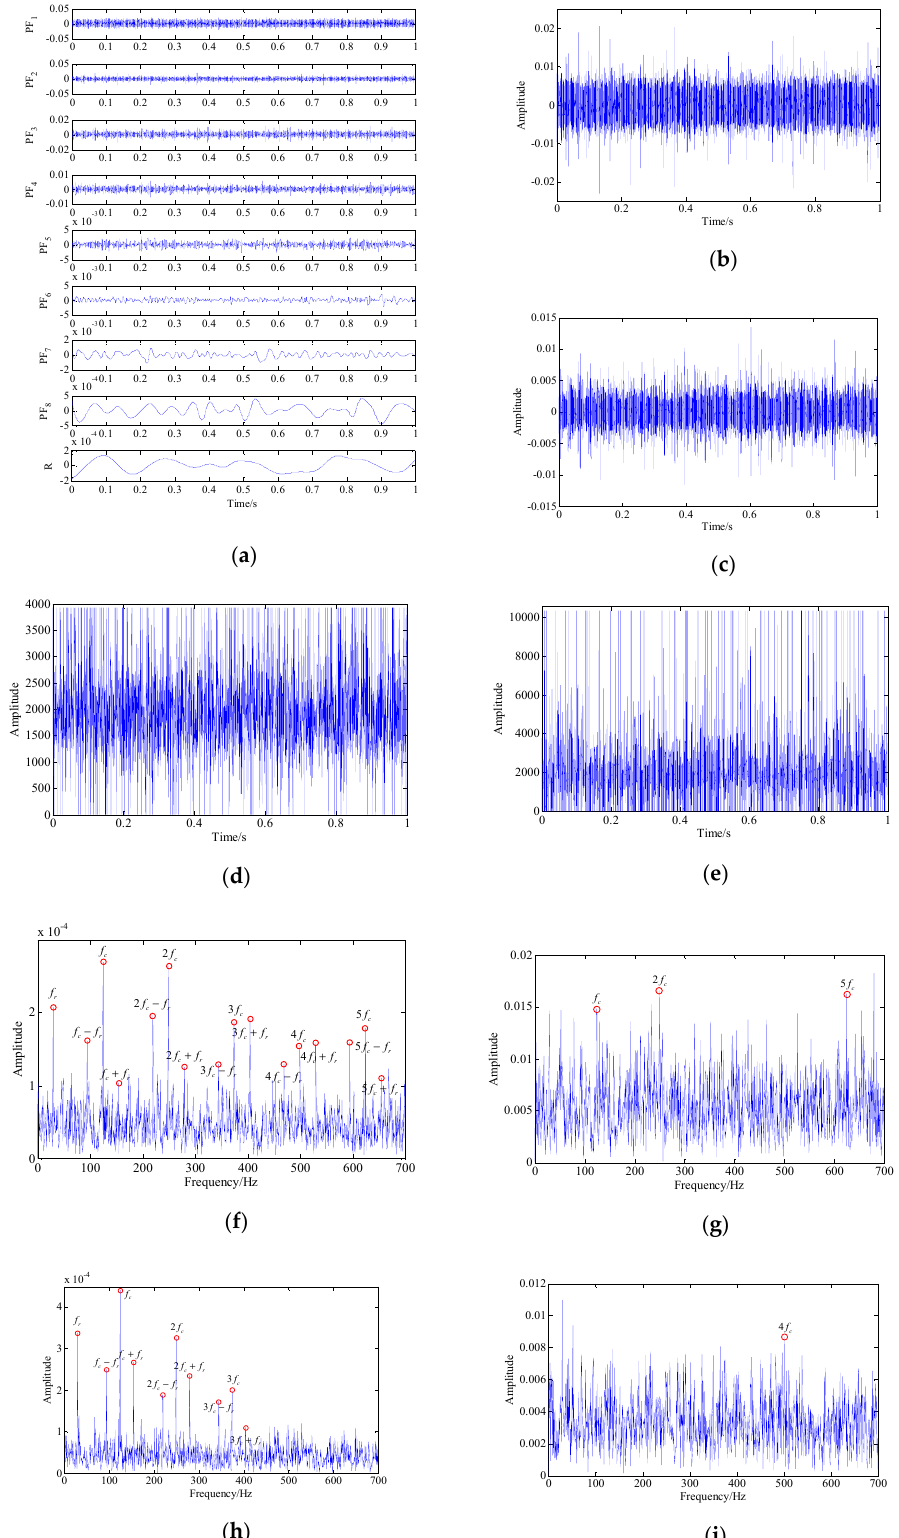
Figure 9. Simulation signal and analysis results determined by the demodulation analysis technique based on local mean decomposition (LMD) and energy separation: ( a ) waveform of the product functions (PFs) and residuals; ( b,c ) waveform of PF2 and PF3; ( d , e ) instantaneous frequency waveform of PF2 and PF3; ( f,h ) envelope spectra of PF2 and PF3; ( g,i ) instantaneous frequency spectra of PF2 and PF3.